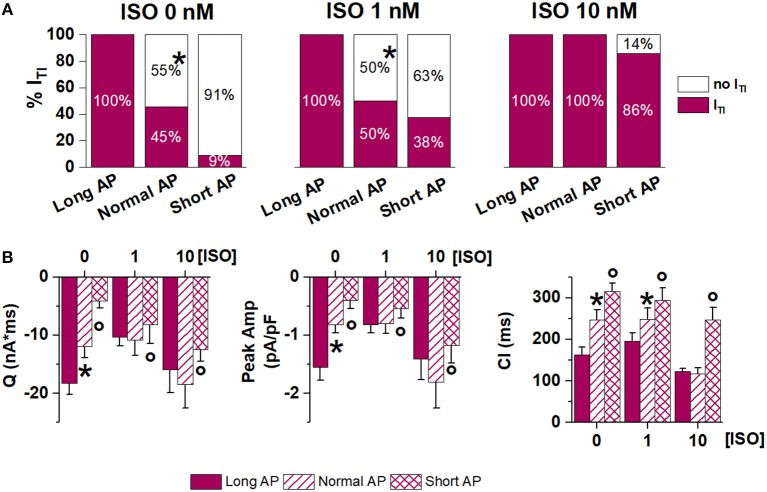
Effect of APD shortening within the same ATII-treated cardiomyocyte (Long AP, Normal AP and Short AP waveforms). (A) ITI incidence in basal condition (ISO 0) and in 1 nM and 10 nM ISO. (B) statistics (mean ± S.E.) of ITI charge (Q), peak ITI amplitude (Peak Amp) and coupling interval (CI). N > 8 for all groups *p < 0.05 vs. Long AP; °p < 0.05 vs. Normal AP.